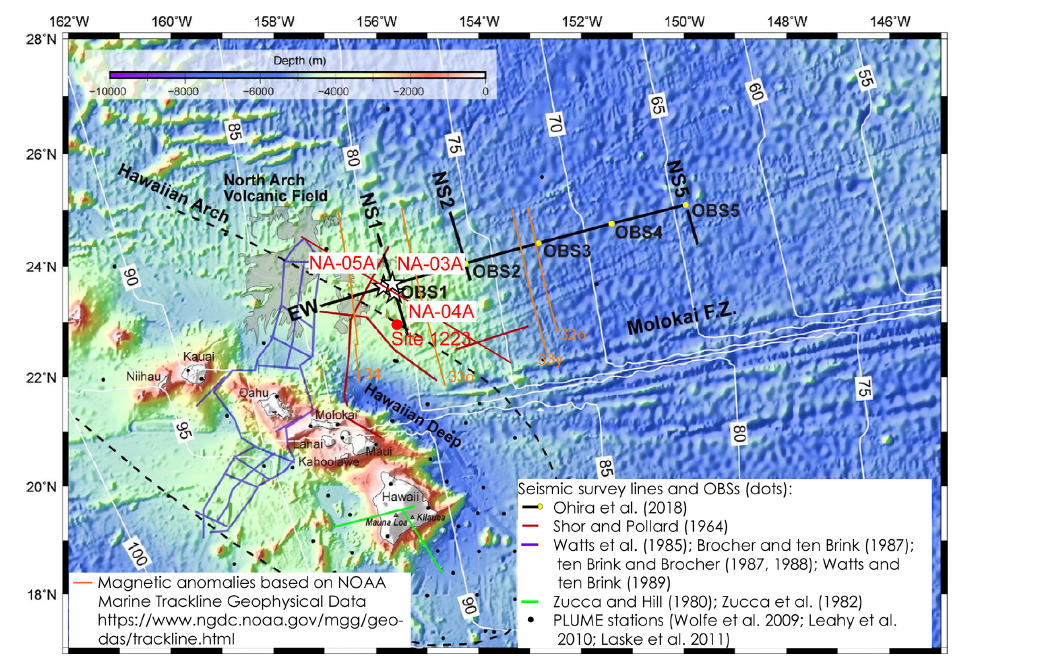
Figure 1. Proposed drill sites (primary site: NA-03A; alternative sites: NA-04A and NA-05A) and the bathymetry of the North Arch Volcanic Field (after Ohira et al., 2018). White lines with numbers are seafloor age (Ma) after Müller et al. (2008).